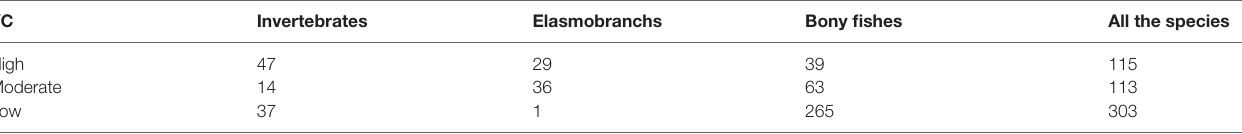
TABLE 1 | The overall vulnerability of the 531 evaluated